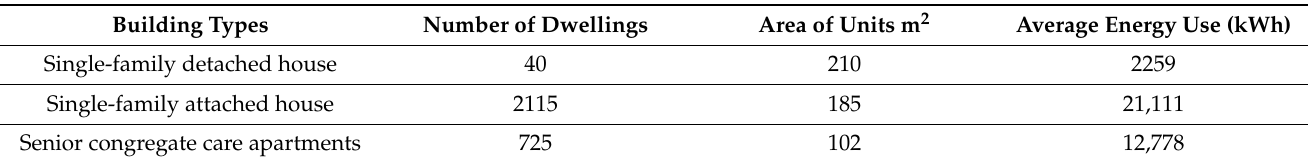
Table 4. Proposed model for the case study, a medium-scale community in the Okanagan Valley, BC, Canada. Data from Bakhtavar et al. [57].